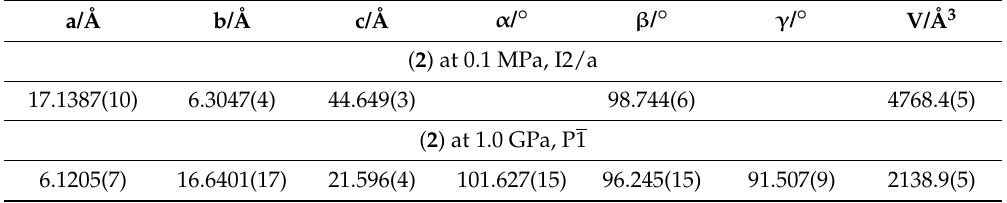
Table 4. The unit cell parameters for ( 2 ) before and after the phase transition.